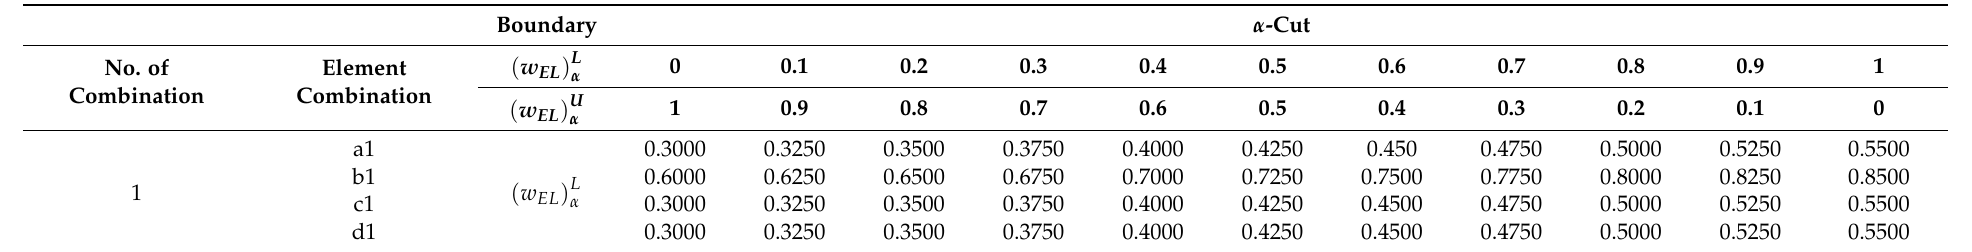
Table 7. The α -cut sets of elements fuzzy structural importance according to each combination (shortened version-the first and the last two combinations). Boundary α